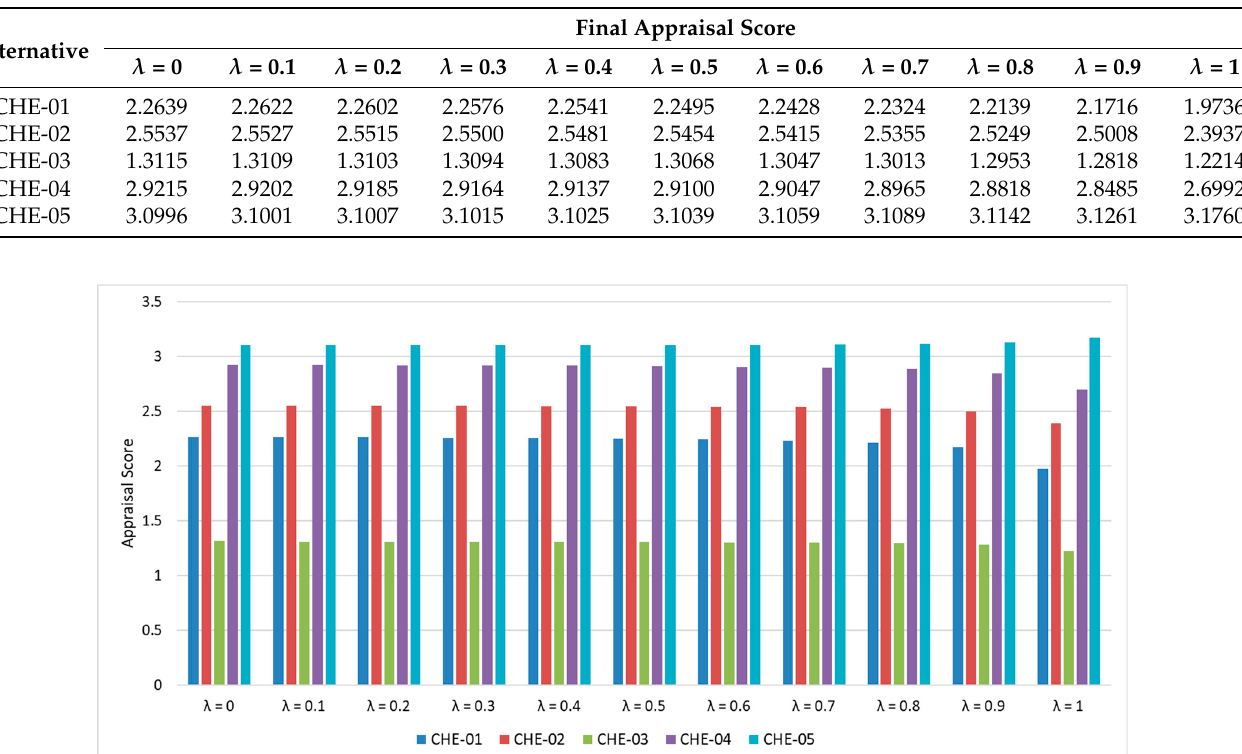
Table 13. The final performance score of the CoCoSo model with different λ values.